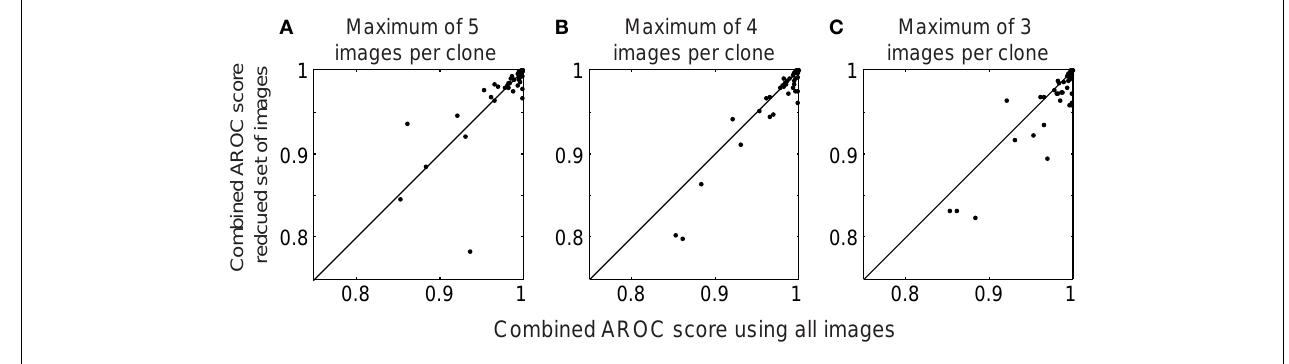
combined AROC scores using all images. (B,C) Same as (A) , except using a maximum of 4 and 3 images to form the templates,